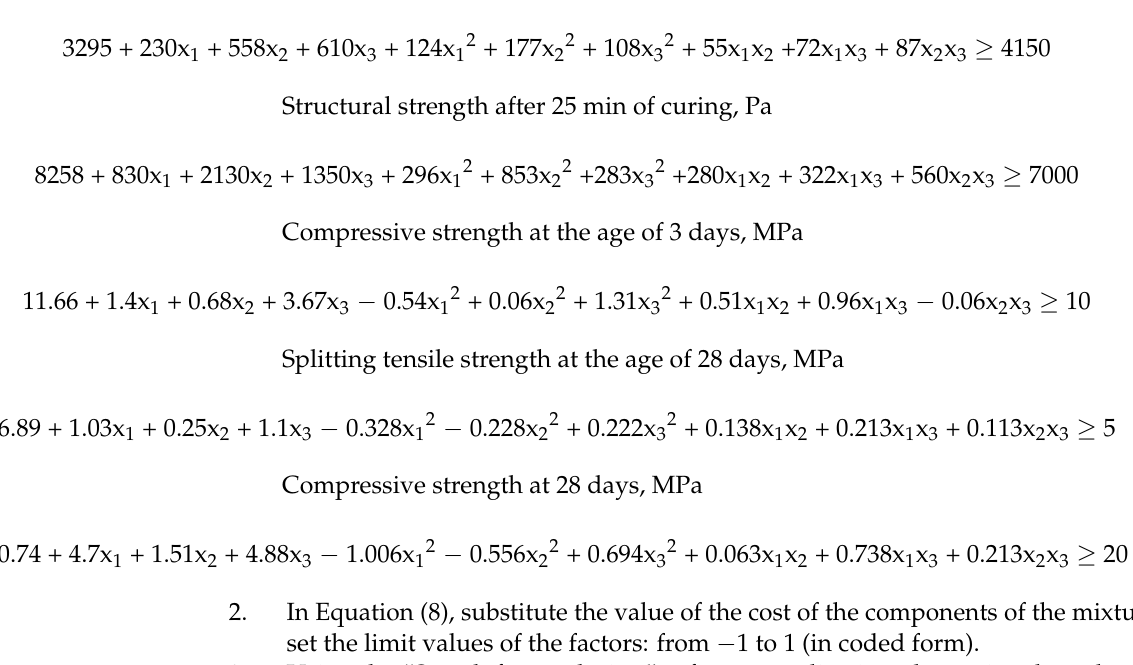
2. In Equation (8), substitute the value of the cost of the components of the mixture, and set the limit values of the factors: from − 1 to 1 (in coded form). 3. Using the “Search for a solution” software application, determine the values of the factors that satisfy the accepted constraints of the problem, and minimize the total cost of the